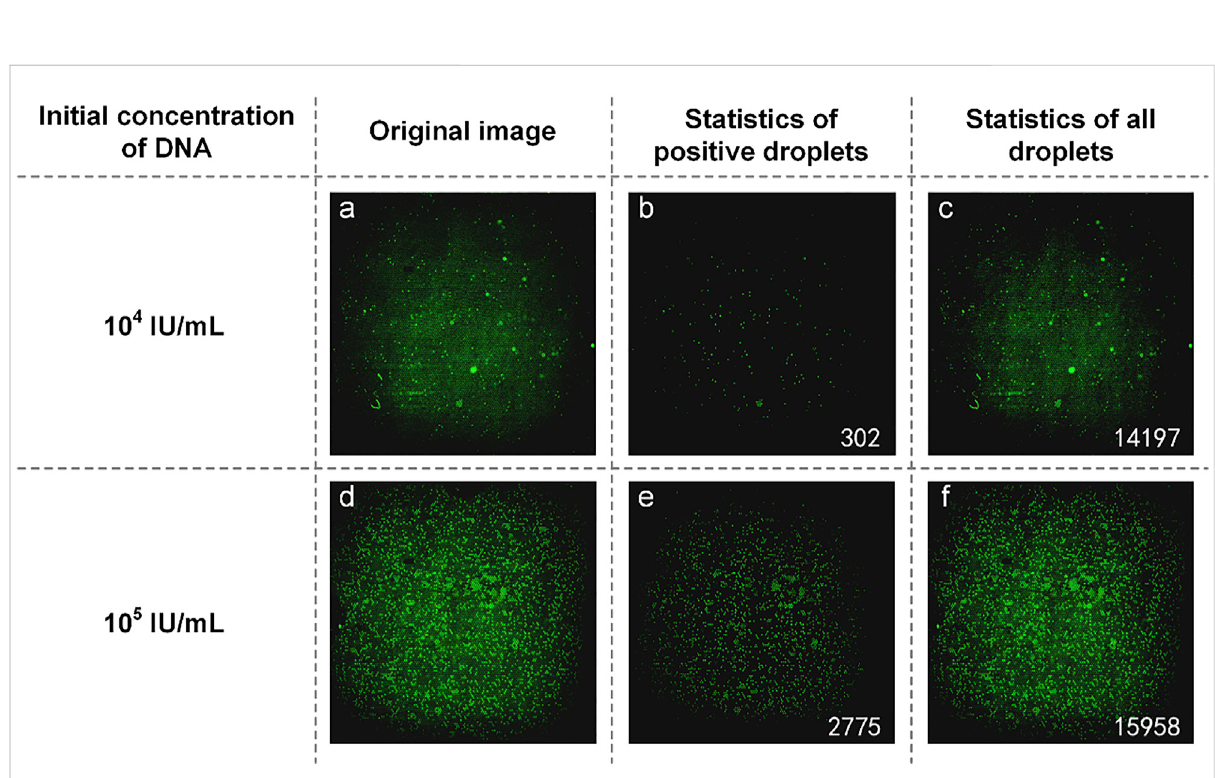
FIGURE 4 (A) Original image of HBV DNA with an initial concentration of 10 4 IU/ml; (B) Image processed by software and the number of positive droplets with low-concentration DNA; (C) Statistics of all droplets containing HBV DNA with an initial concentration of 10 4 IU/ml; (D) Original image of HBV DNA with a concentration of 10 5 IU/ml; (E) Image processed by software and the number of positive droplets with high-concentration DNA; (F) Statistics of all droplets containing HBV DNA with an initial concentration of 10 5